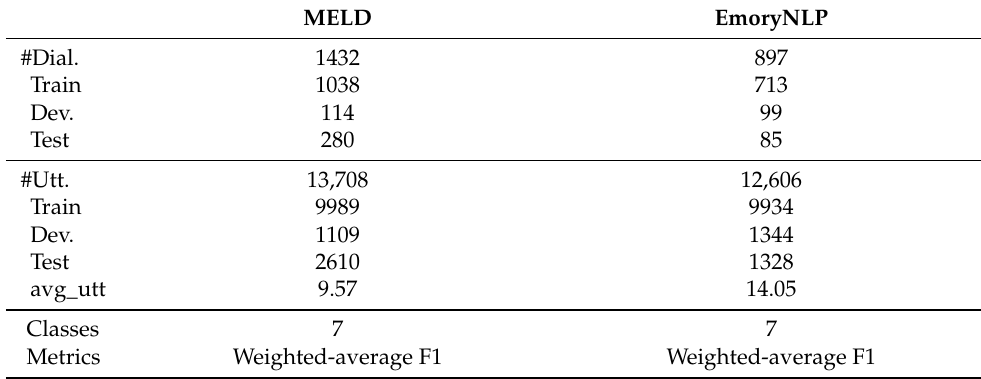
Table 1. The statistics of the datasets . avg_utt denotes the average number of utterances. MELD